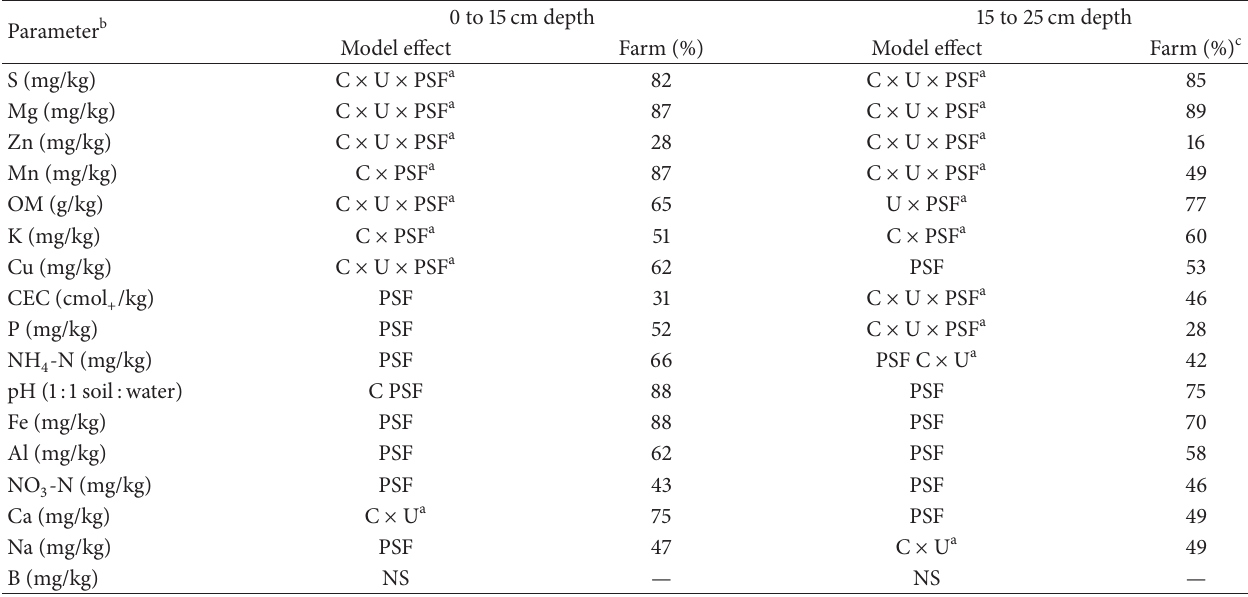
Table 4: Soil chemical models in 0 to 15 cm and 15 to 25cm strata selected from candidate fixed effects of compost (C), urea (U), compost × urea (C × U), preexperiment soil fertility for each parameter sampled at 15 to 25 cm depth (PSF), and significant interactions, with block included as a random